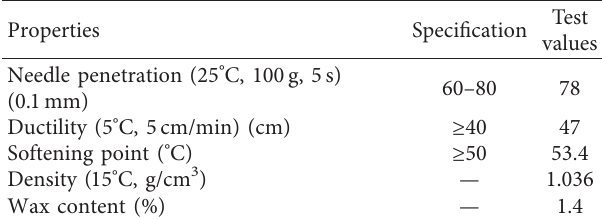
Table 2: Properties of original bitumen.